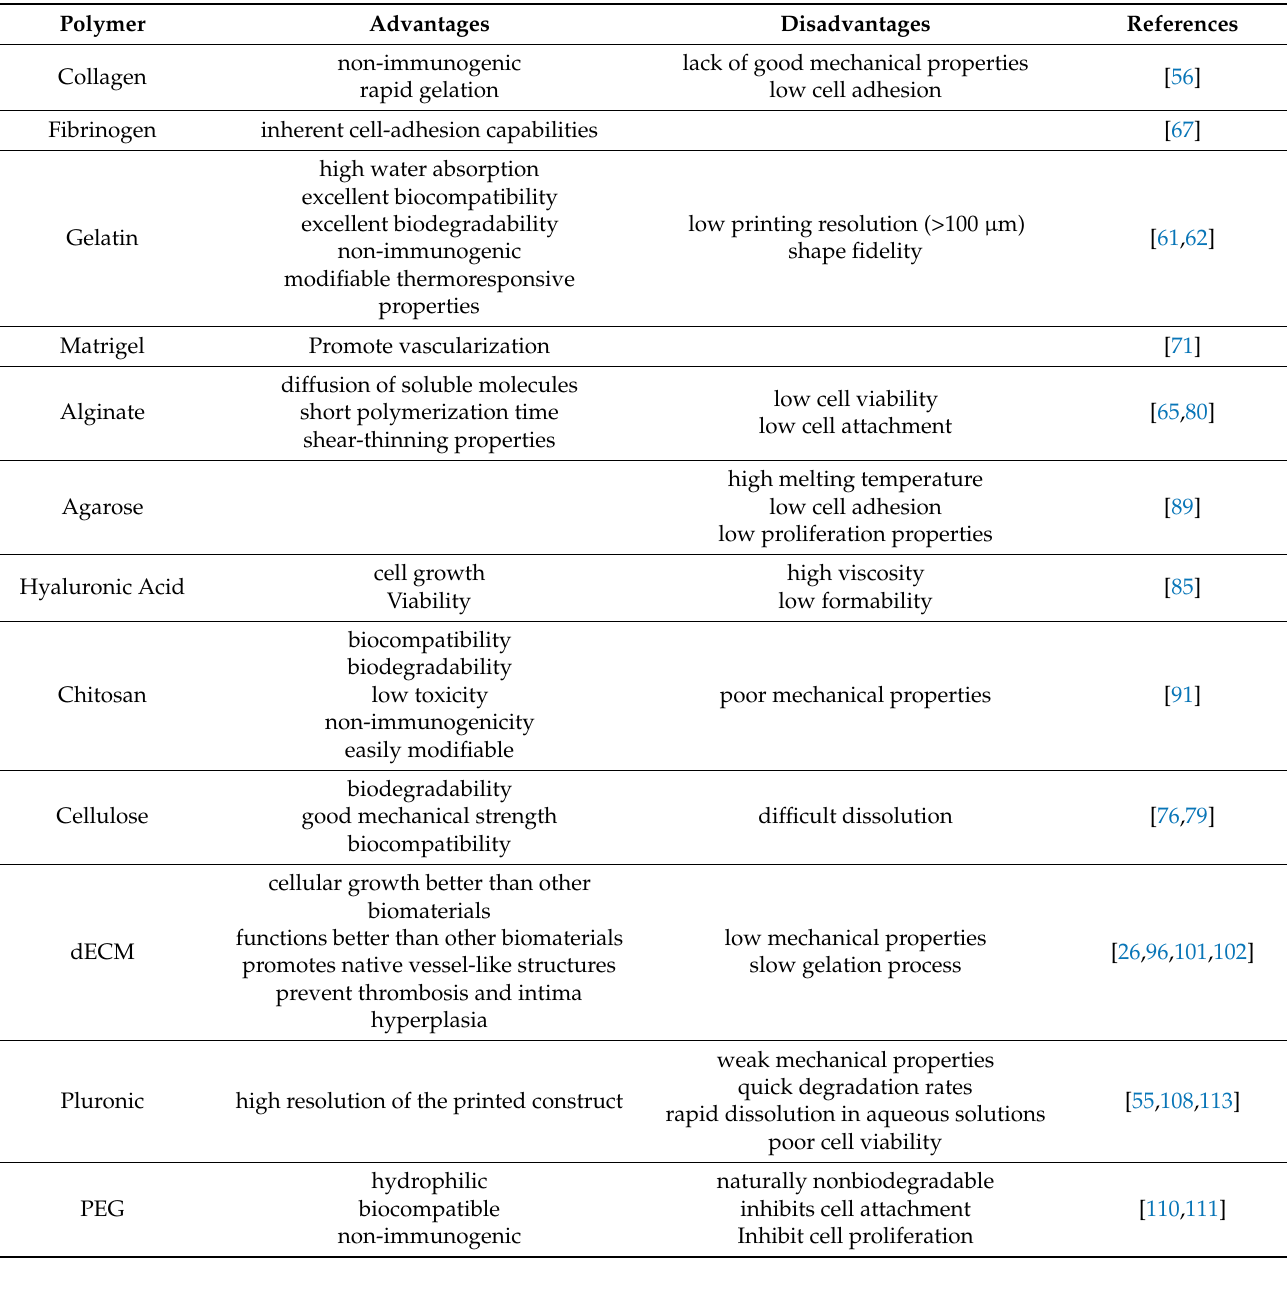
Table 2. Advantages and Disadvantages of the Main